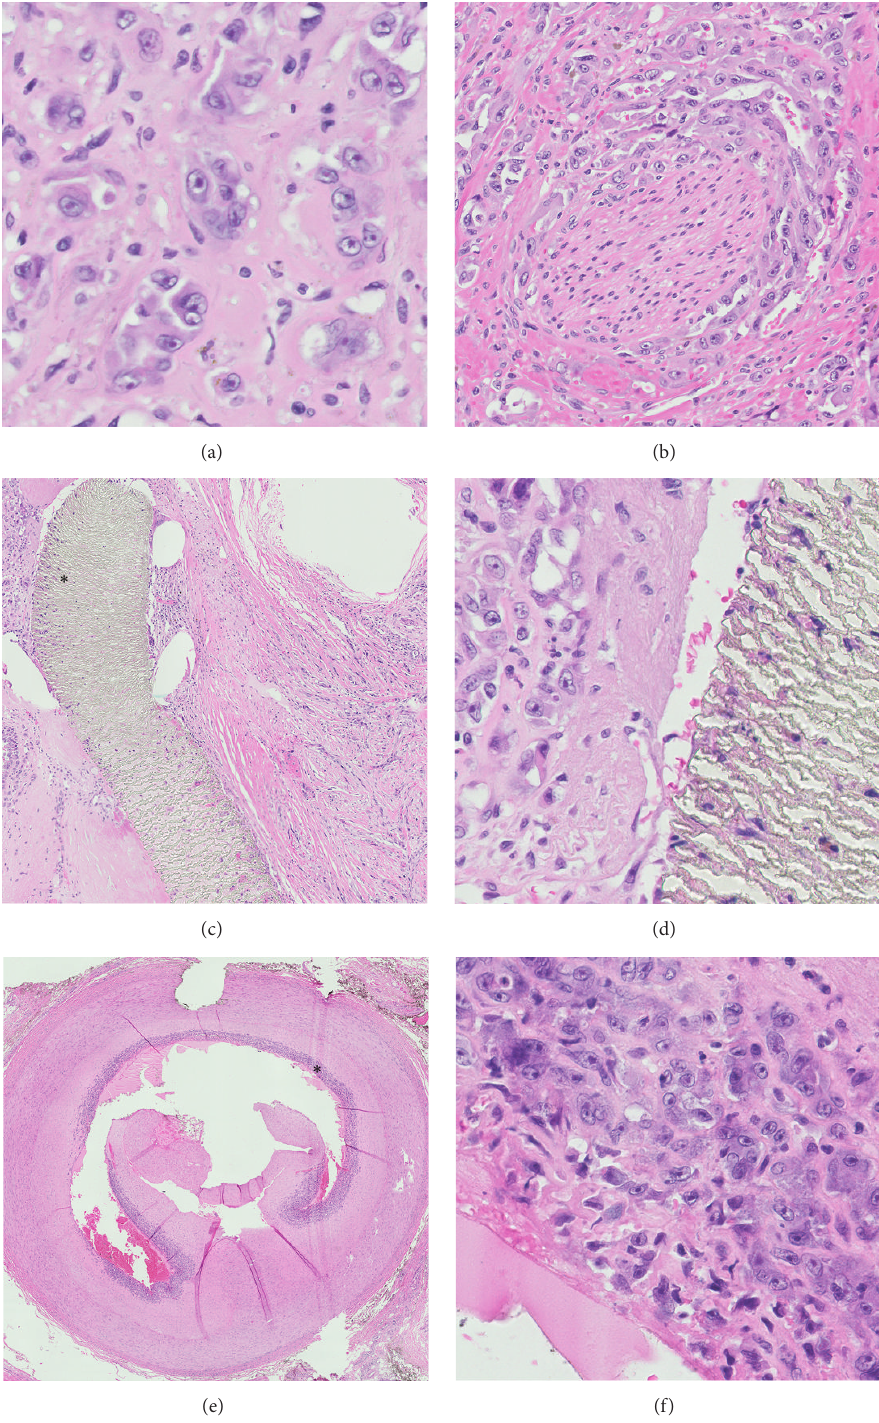
Figure 3: Microscopic examination, amputation specimen. (a) Clusters of malignant epithelioid cells, similar to those seen in the biopsy specimen, are noted (original magnification × 400). (b) Perineural invasion can explain the patient’s pain symptoms (original magnification × 200). (c) Tumor clusters are embedded within the dense fibrous sheath around the graft material; the region marked by the asterisk is shown at higher power in (d) (original magnification × 50, × 400). (e) Tumor cells are seen tracking along the intimal layer of a large artery; the region marked by the asterisk is shown at higher power in (f) (original magnification × 10, ×